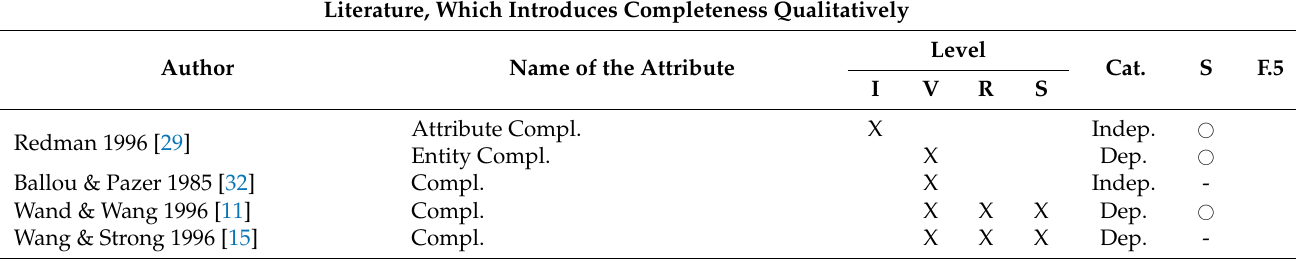
Table 1. Classification of the state-of-the-art research in